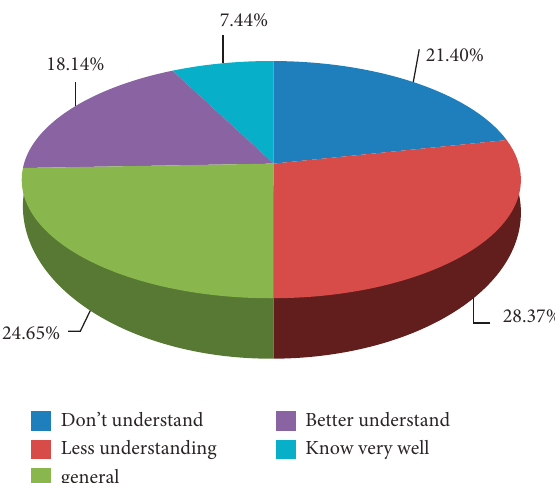
Figure 5: Respondents’ understanding of garbage classification